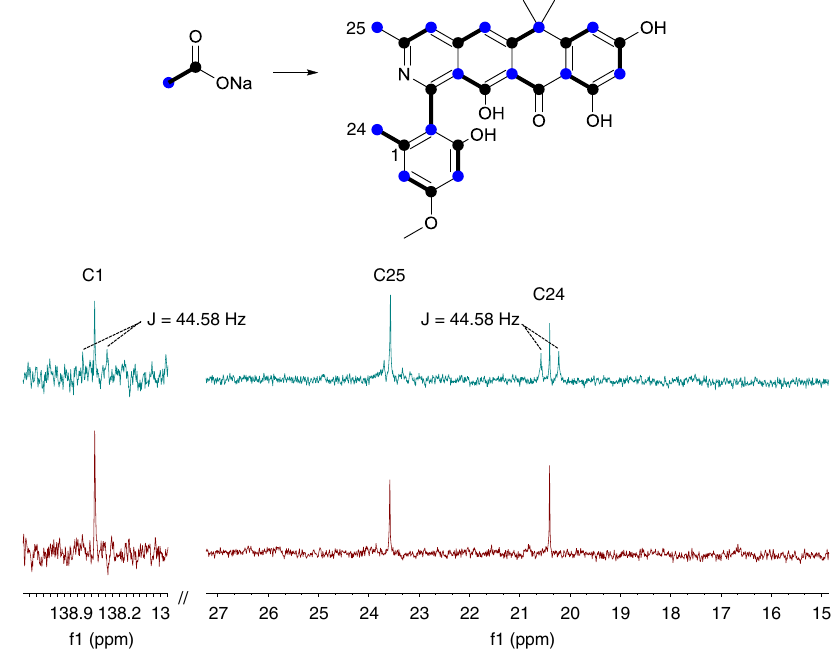
Fig. 5 The methyl group carbon C25 arises from C2 of acetate. Comparison of 13 C NMR spectra for 2 isolated after growth in the presence of [1,2- 13 C 2 ] sodium acetate. Integration of the 13 C NMR spectra con fi rmed weak enrichment of the 13 C isotope and the absence of coupling to any adjacent carbon atom. In contrast, the methyl group atom C24 shows enrichment and coupling to C1. The C2 atom of [1,2- 13 C 2 ] sodium acetate is highlighted as a blue circle, the C1 atom as a black circle, and the coupled unit by a bold